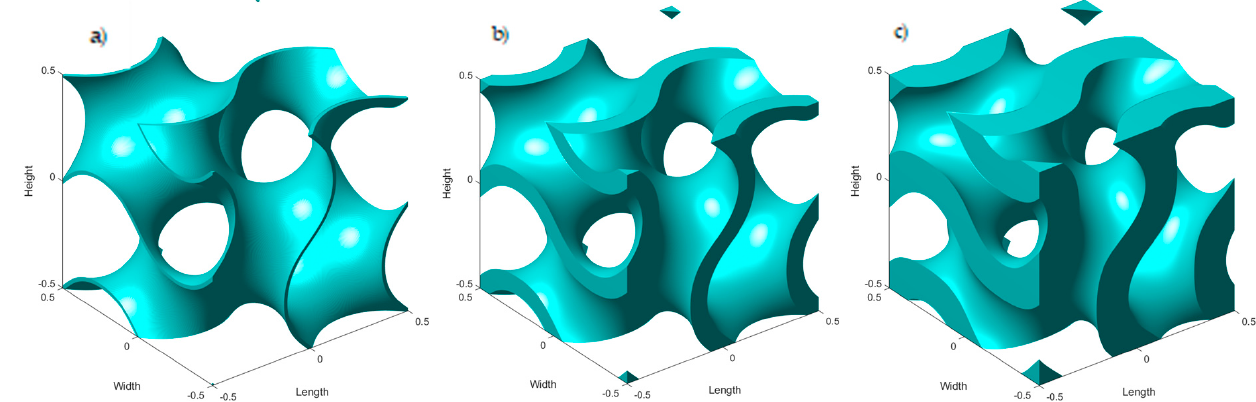
Figure 3. TPMS, gyroid, of relative density: ( a ) 5%, ( b ) 25%, ( c ) 45%. The TPMS structure shown in Figure 3 is the so-called sheet network [92], where the wall separates two domains. Another variation of the TPMS structure is the so-called solid network [83]. A solid network TPMS is created when one of the domains is replaced with a solid. Then, there is a structure composed of a solid body and a space that one fluid can flow through. An example of the structures of TPMS sheet and solid types is shown in Figure 4.